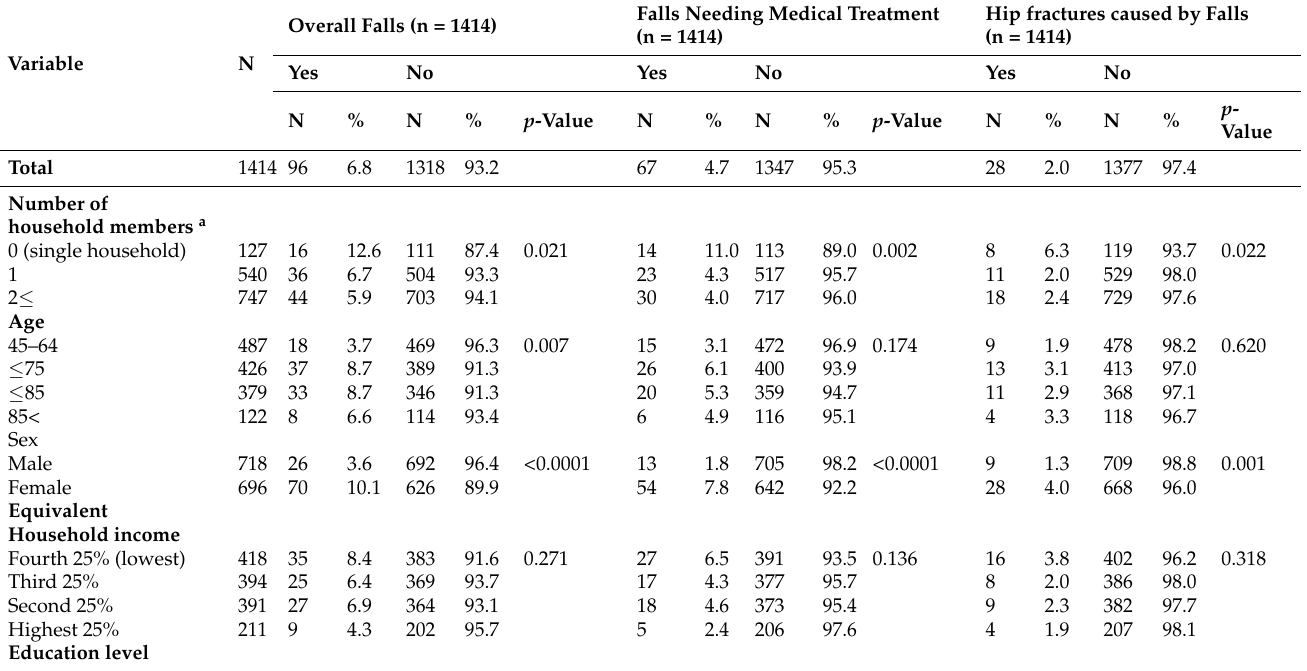
Table 1. General characteristics by incidence of overall falls, falls needing medical treatment, and hip fractures caused by